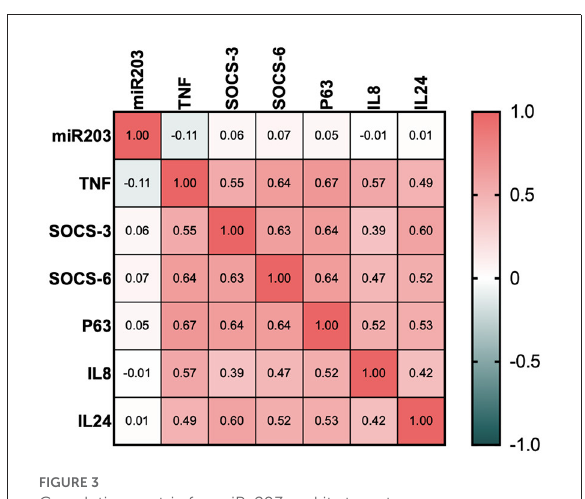
[ − 6.6 ( − 9.5–3.5)], IL-8 [ − 8.4 ( − 12.4–4.1)], and IL-24 [ − 5.6